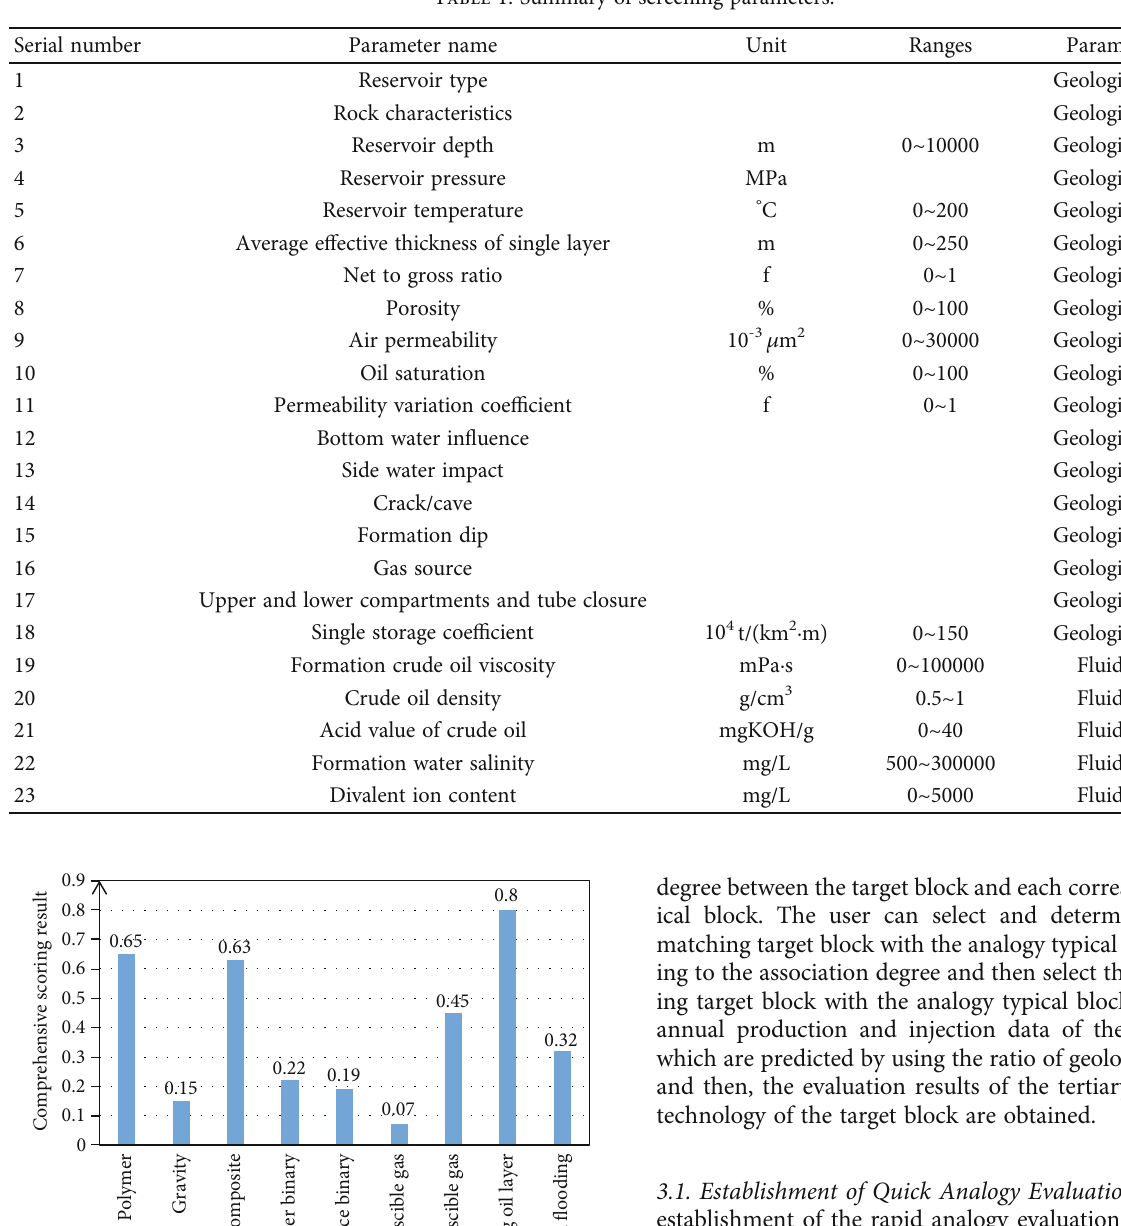
Table 1: Summary of screening parameters.